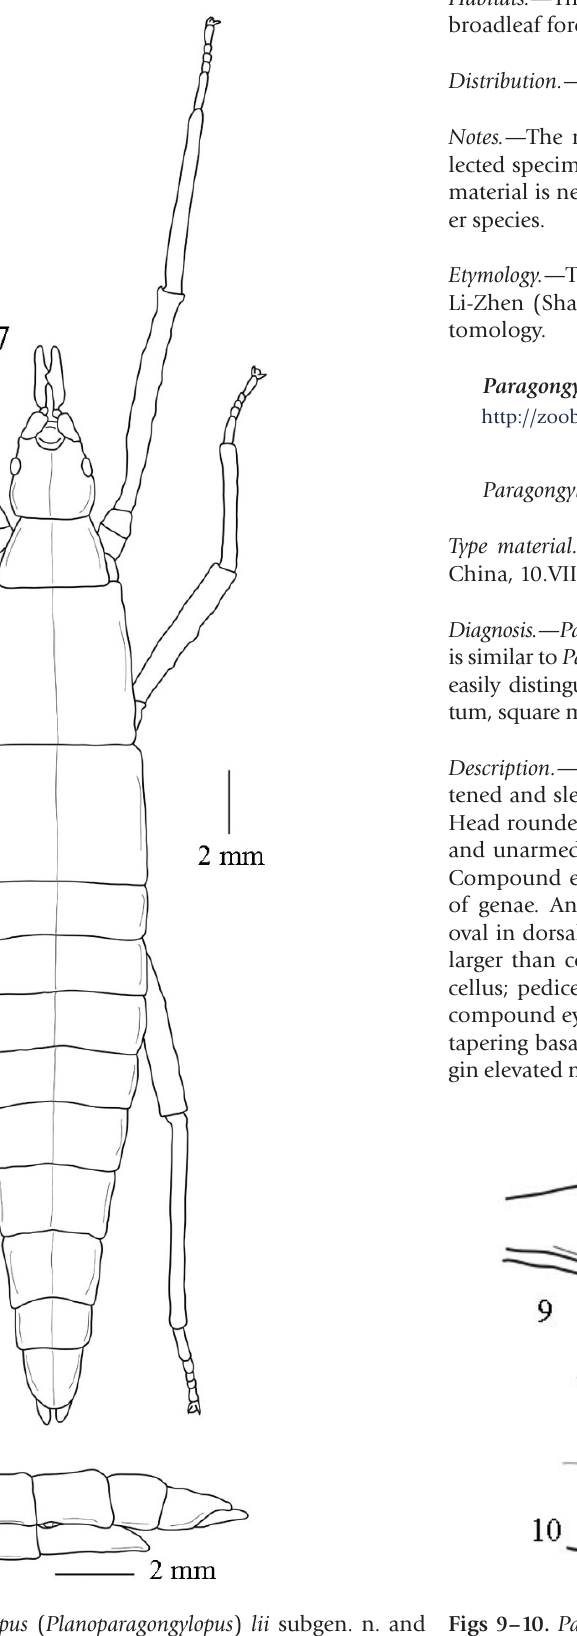
Figs 7–8. Paragongylopus ( Planoparagongylopus ) lii subgen. n. and sp. n. 7. ♀ , body and legs, dorsal view; 8. ♀ , apex of abdomen, lateral view.